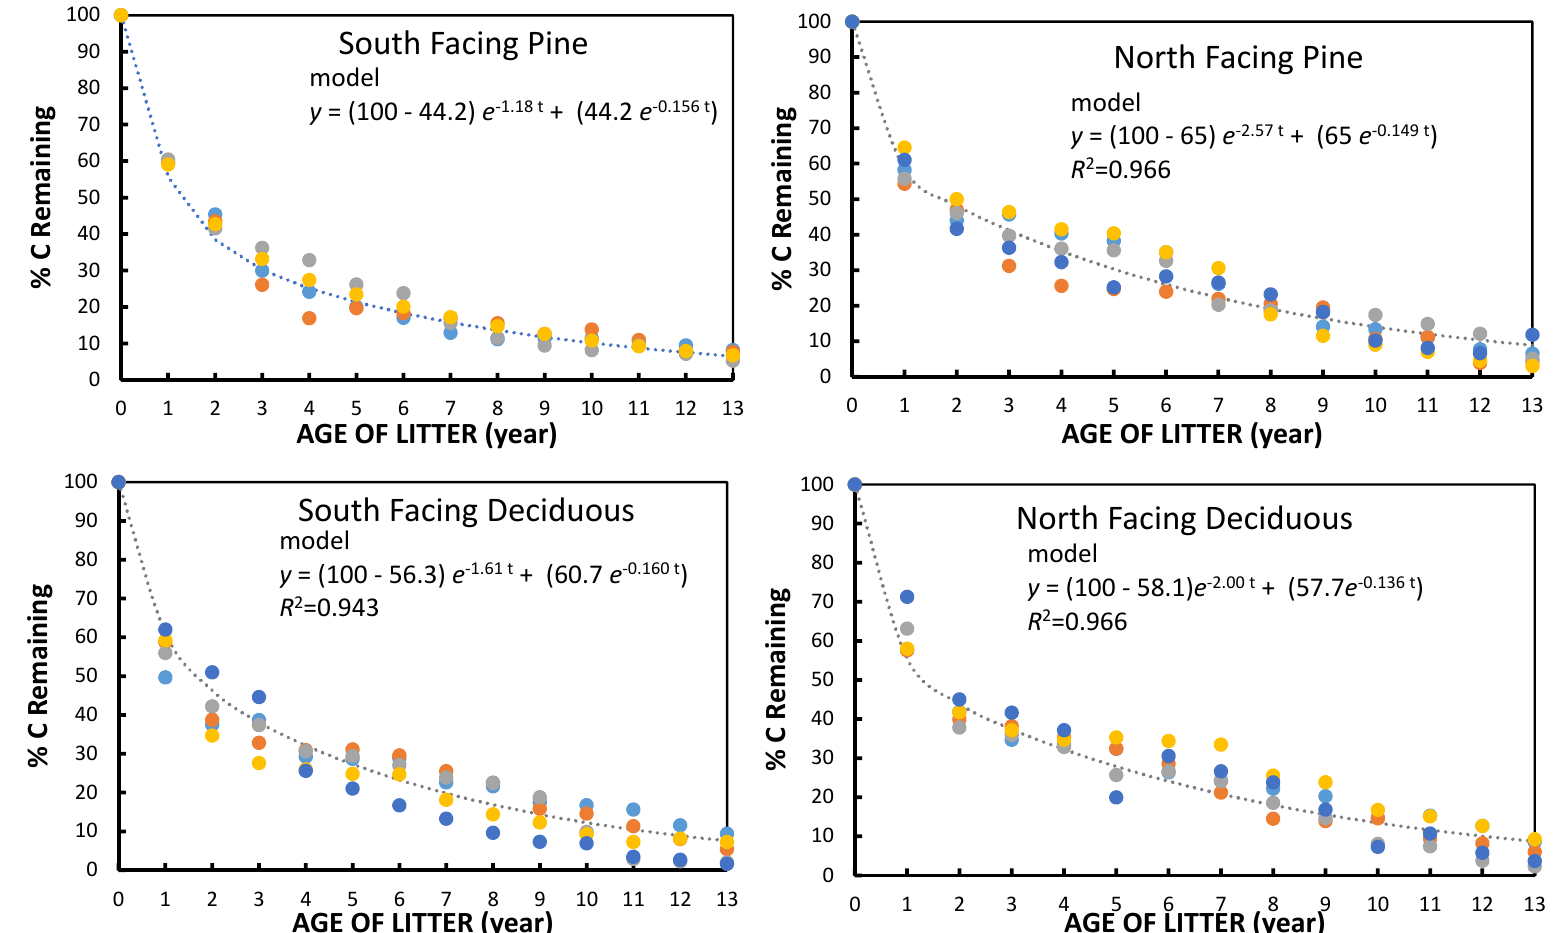
Figure 1. Decomposition of forest floor C as a percentage of litterfall C: pine plantation watersheds. Colors of points indicate individual plots.